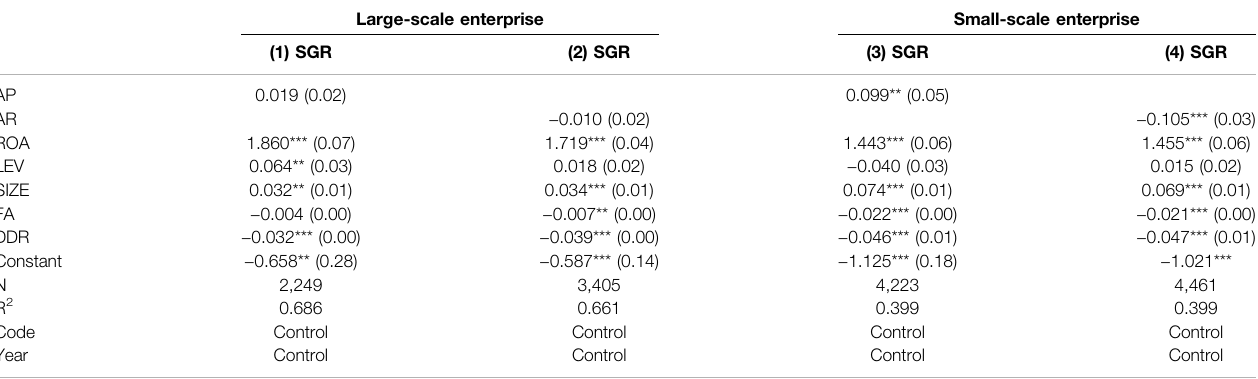
TABLE 8 | Heterogeneity analysis: Division of enterprise